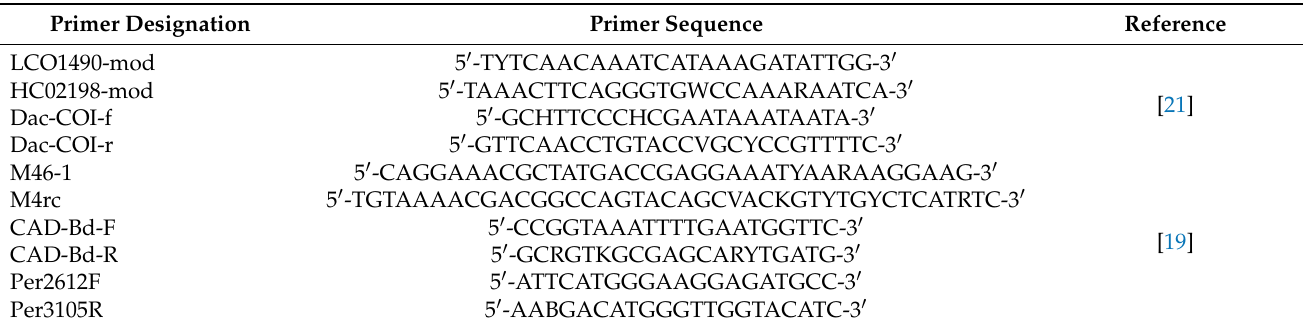
Table 2. Oligonucleotide primers used in this